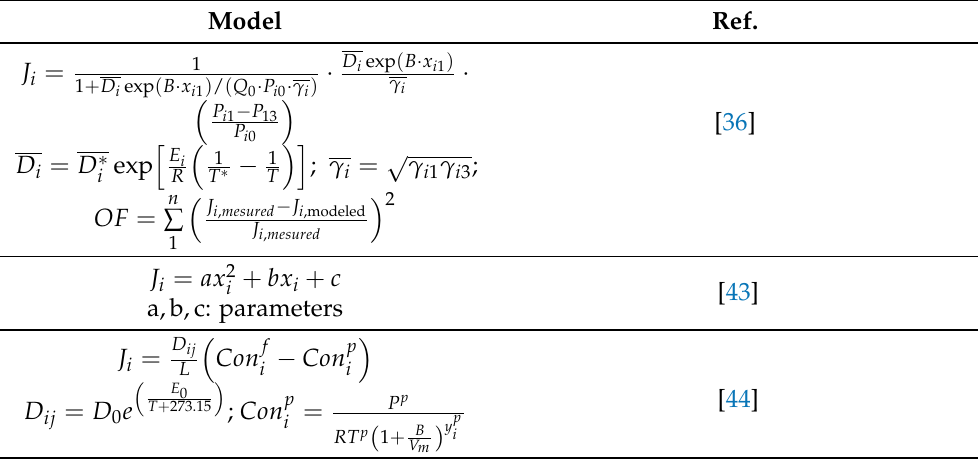
Table 1. Permeate flux